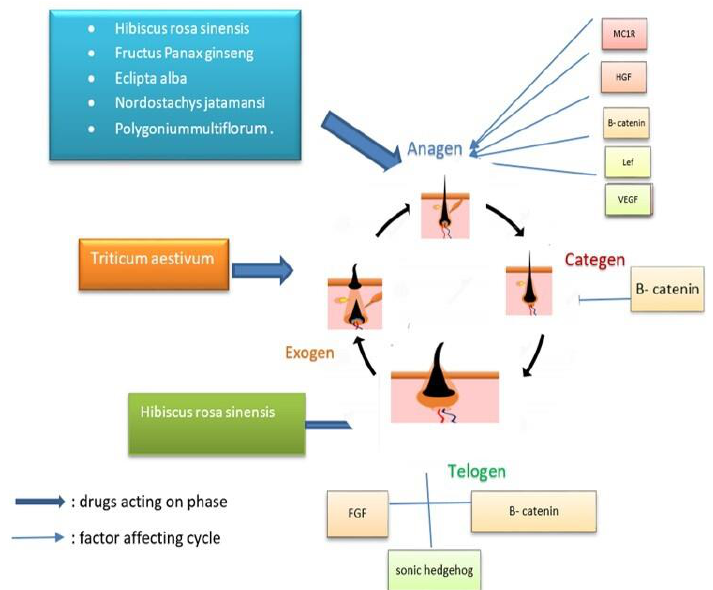
Figure 5. Drugs act on the hair cycle and factors affecting it. Wnt signaling is very important for the hair follicle. Wnt/b-catenin and Shh are anagen-inducing factors. Insulin-like growth factor (IGF-), vascular endothelial growth factor (VEGF), and hepatic growth factor (HGF) are also involved in the anagen phase [82]. The FGF5 induces catagens, and deficiency of it leads to prolonged anagen phases [83]. Factors TGF-b, BDNF, BMP2/4, and interleukin-b also trigger catagen induction [82] . Hibiscus rosa-sinensis , fructus Panax ginseng , Eclipta alba , Nardostachys jatamansi , Polygonum multiflorum all acts on the anagen phase. 5.2.2. Hair Follicle Telogen Phase When the duration of the telogen phase is prolonged, relatively more hair follicles are shed. New hair follicles do not enter the anagen phase to form new hair fiber [81]. This results in the development of alopecia. To overcome this, natural drugs can act upon the telogen phase, e.g., from Hibiscus rosa-sinensis , to reduce its duration. 5.2.3. Hair Follicle Exogen Event The prolonged anagen phase does not contribute to the increase in hair density. In- stead, exogen and anagen phases combined contribute to the increase in hair density. There is an increased number of hair fibers if there is no shedding in the exogen phase. Old telogen phase hair fiber and new anagen phase hair follicles exist in the same hair follicle [81]. 5.2.4. Dystrophic Anagen Growth Phase A condition where the hair fiber does not form even though the follicle is active is called anagen effluvium. Herbal medicine act at this phase and overcomes anagen efflu- vium [81].